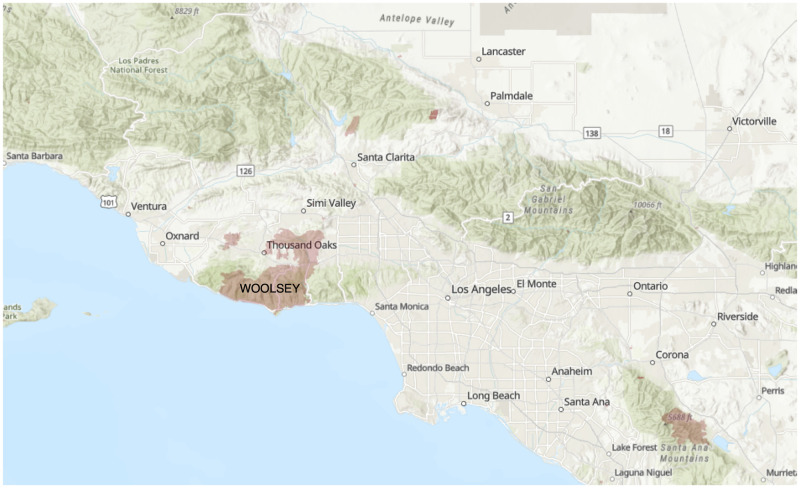
2018 Woolsey Fire Burn Area [35].